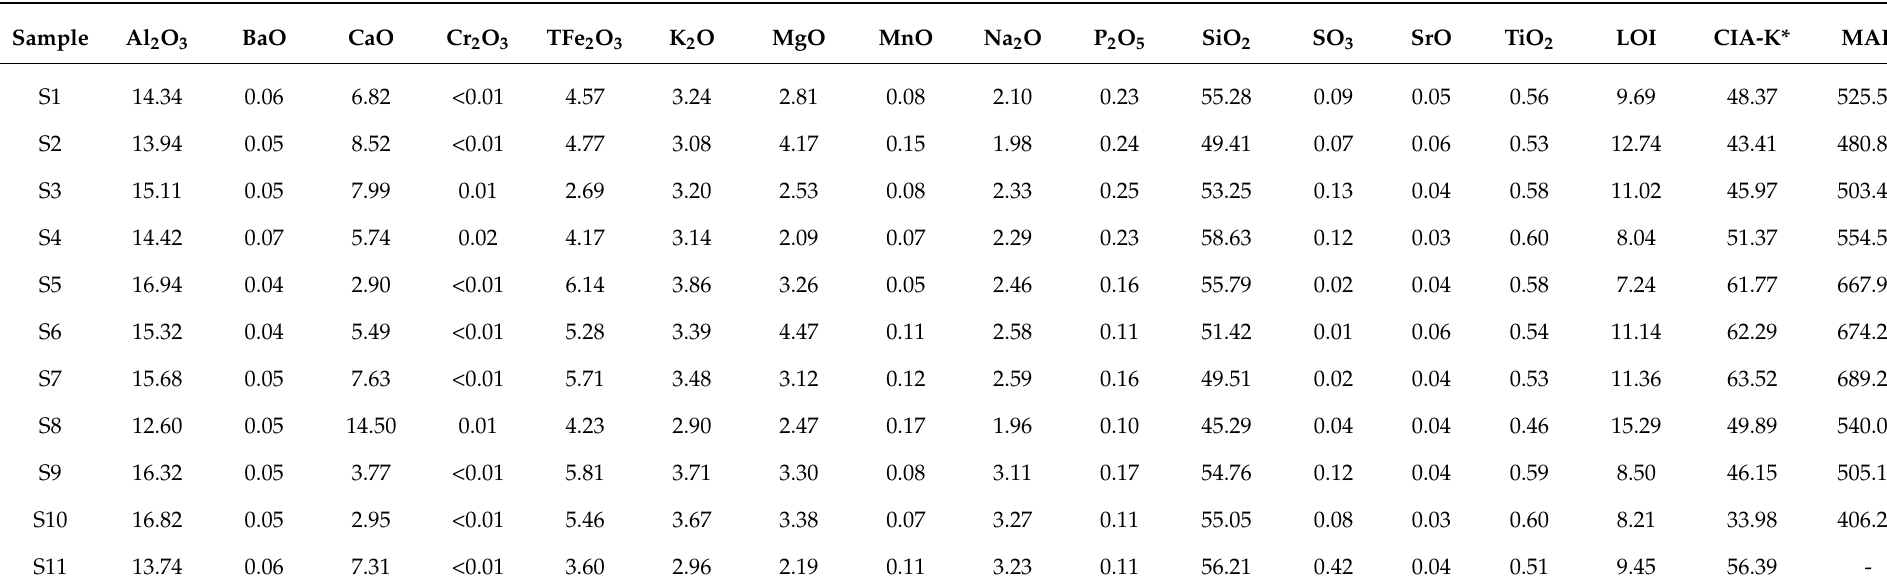
Table 1. The amount of major oxides (wt %), LOI (loss on ignition) (%), CIA-K* (chemical index of alteration without potash), and MAP (mean annual precipitation) in rock samples. See the location of the samples in Figure